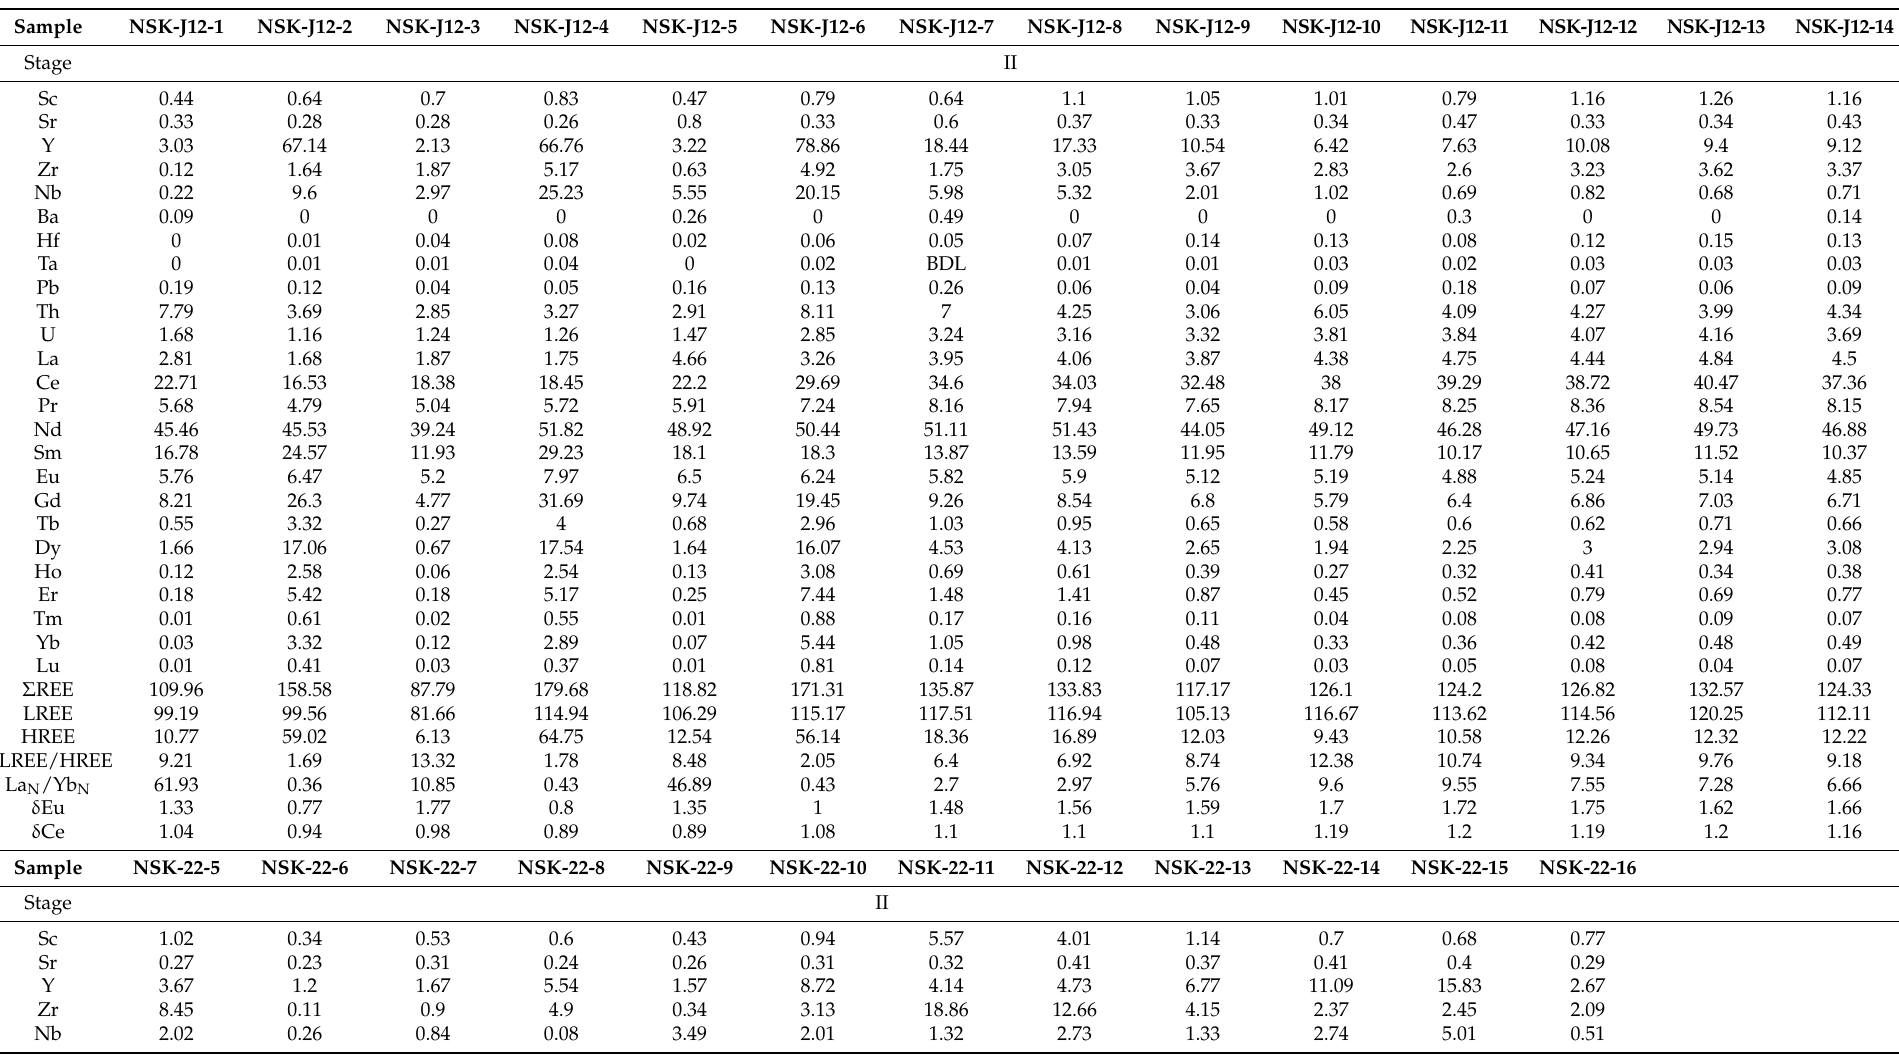
Table 2. LA–ICP–MS analysis of garnets from the Nanminghe iron deposit